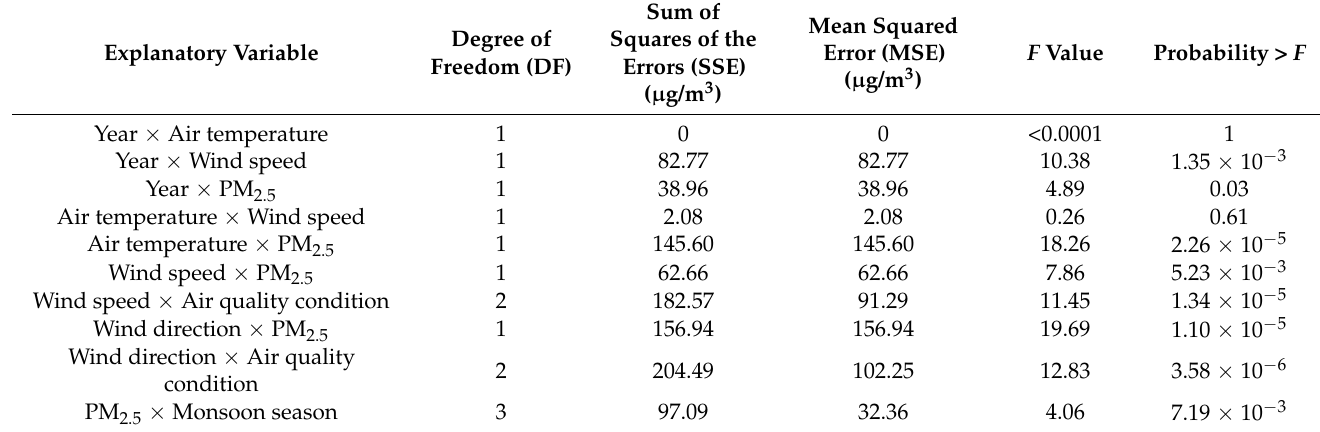
Table 4. Results of sum of squares of the errors (SSE) analysis on the ANCOVA model for estimating daily PM 2.5 concentration in Singapore from March 2016 to February 2018 for selected explanatory